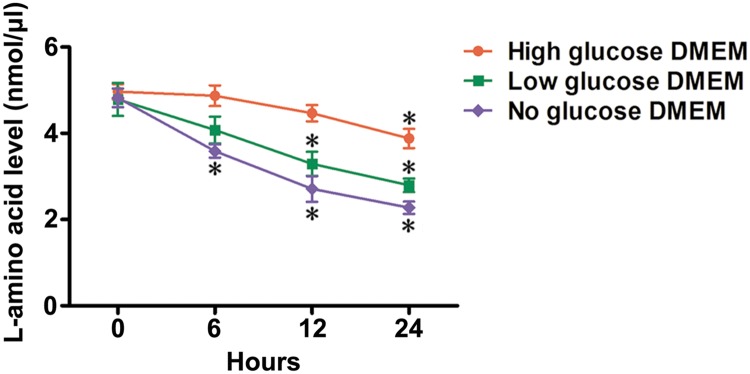
L-amino acid level in cultured supernatant of different DMEM.L-amino acid level in cultured supernatant of high, low, and no glucose DMEM was quantified at 0, 6, 12, and 24 h of feeding. Data were represented as means ± SD. Statistical significance was evaluated by ANOVA. *P < 0.05 versus 0 h.